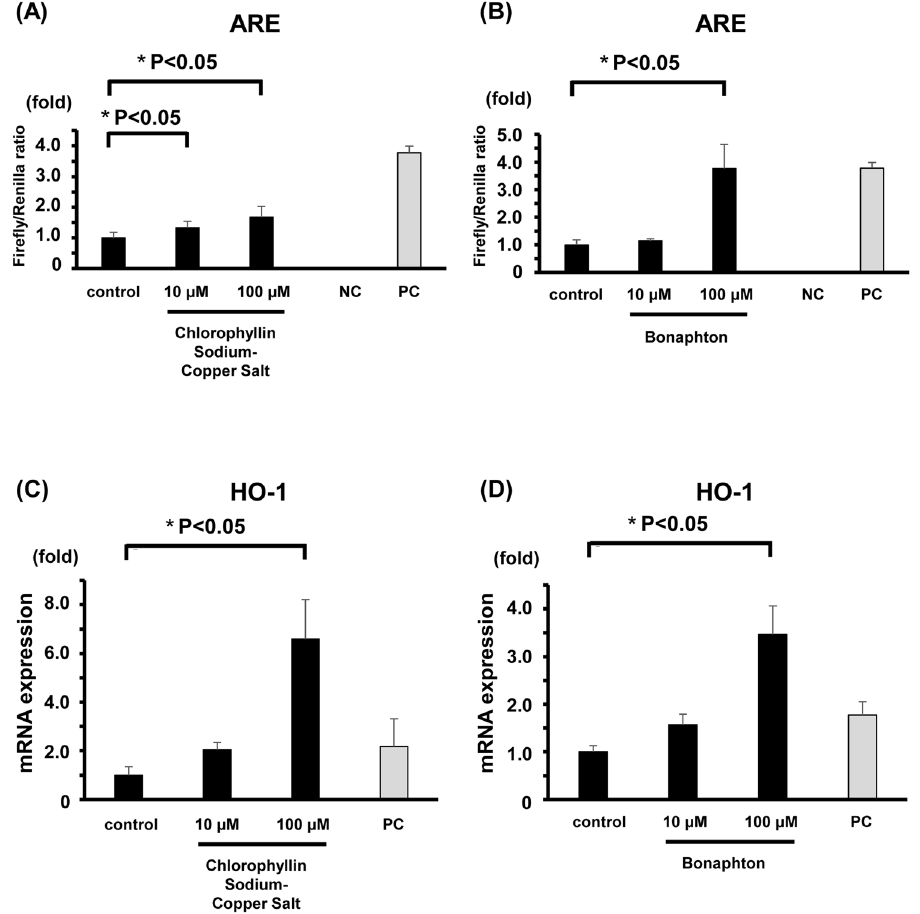
Figure 6. Chlorophyllin sodium copper salt and bonaphton increased ARE promoter activity and HO-1 mRNA expression in HepG2 cells. The luciferase activity of cells transfected with an ARE reporter construct were evaluated 5 h after drug exposure. ( A ) Chlorophyllin sodium copper salt at concentrations of 10 μ M and 100 μ M significantly activated ARE promoter activity. ( B ) Bonaphton at a concentration of 100 μ M significantly activated ARE promoter activity. The negative control was a mixture of a non-inducible reporter construct and constitutively expressed Renilla luciferase construct. The positive control was a constitutively expressed GFP construct pre-mixed with constitutively expressed firefly and Renilla luciferase constructs. Data are expressed as the mean ± S.E.M. * P < 0.05 vs. vehicle-treated cells (control), t-test (n = 3 per experimental group). NC; negative control, PC; positive control. ( C , D ) HO-1 mRNA expression in HepG2 cells 24 h after drug treatments (10 or 100 μ M) was quantified by qRT-PCR. ( C ) Chlorophyllin sodium copper salt (100 μ M) significantly increased HO-1 mRNA expression. ( D ) Bonaphton (100 μ M) significantly increased HO-1 mRNA expression. Five micromolar sulforaphane was used as a positive control (PC) of Nrf2 activation. Data were normalized to actin and expressed as the mean ± S.E.M. * P < 0.05 vs. vehicle-treated cells, t-test (n = 3 per experimental